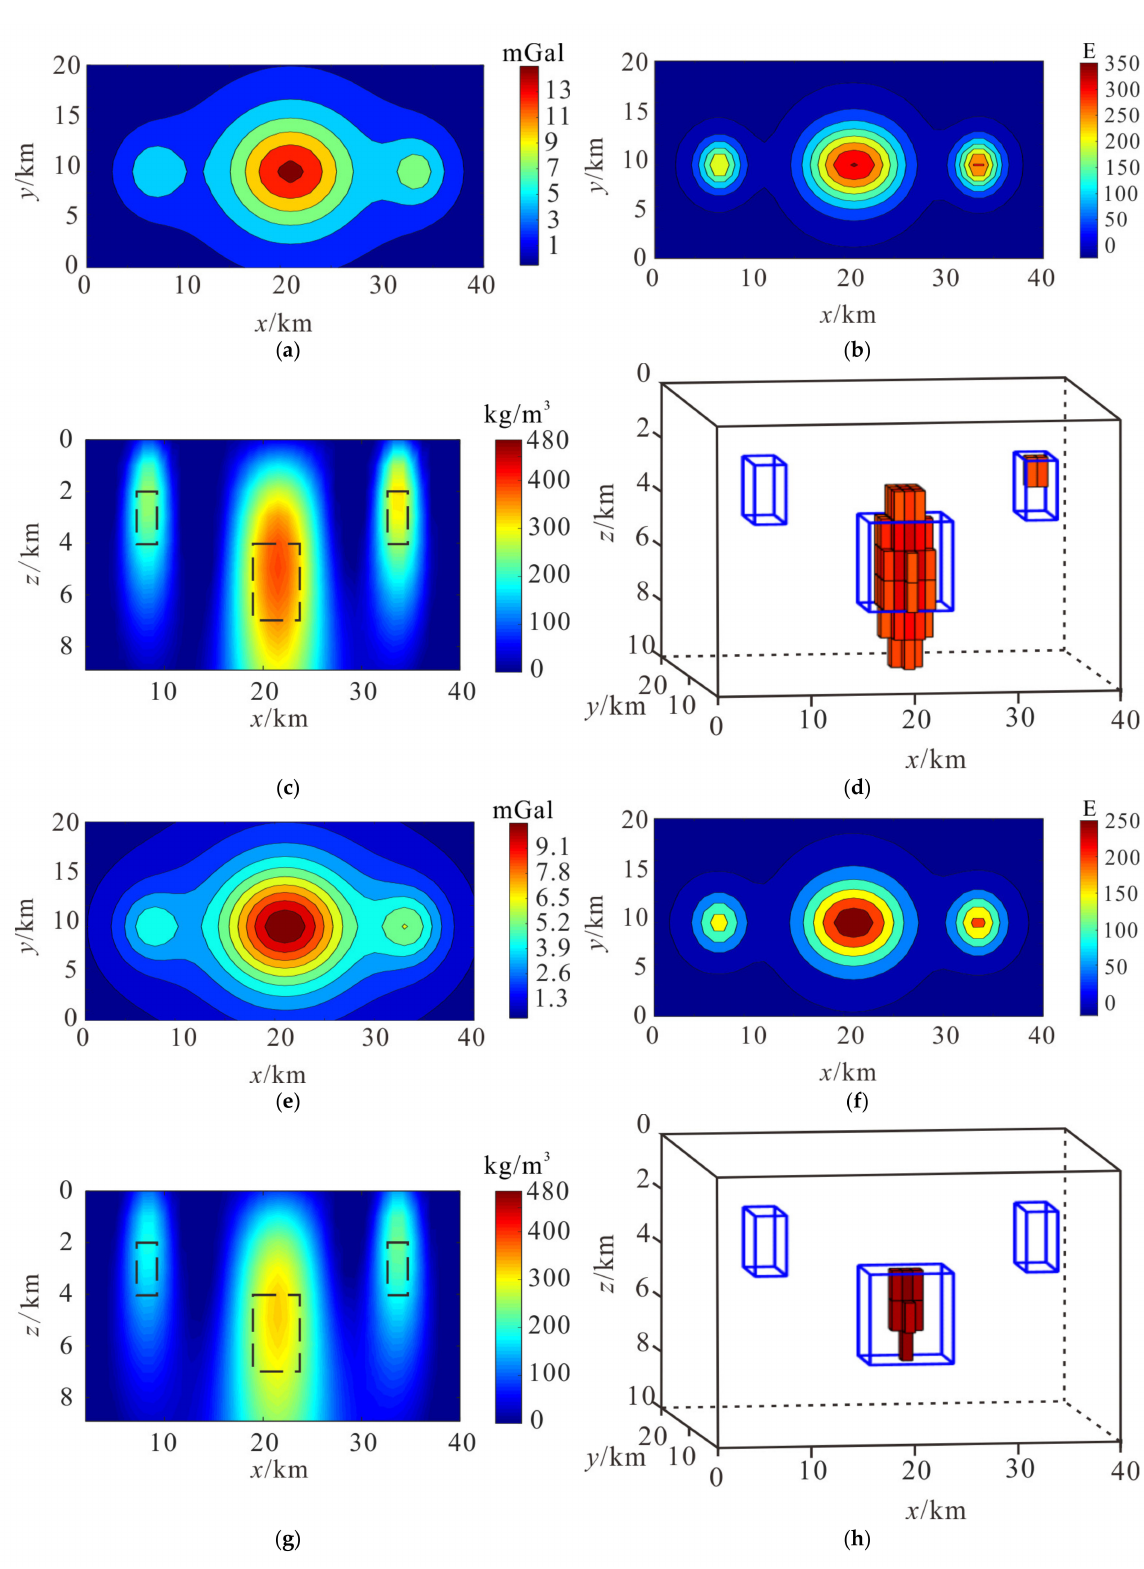
Figure 10. Complex model tests with different altitudes. ( a ) Airborne gravity anomaly at 150 m altitude. ( b ) Vertical gradient anomaly of airborne gravity at 150 m altitude. ( c ) Density slice (y = 10 km) by cooperate density-integrated inversion method at 150 m altitude. ( d ) 3D density distribution (larger than 370 kg/m 3 ). ( e ) Airborne gravity anomaly at 200 m altitude. ( f ) Vertical gradient anomaly of airborne gravity at 200 m altitude. ( g ) Density slice (y = 10 km) by cooperate density-integrated inversion method at 200 m altitude. ( h ) 3D density distribution (larger than 370 kg/m 3